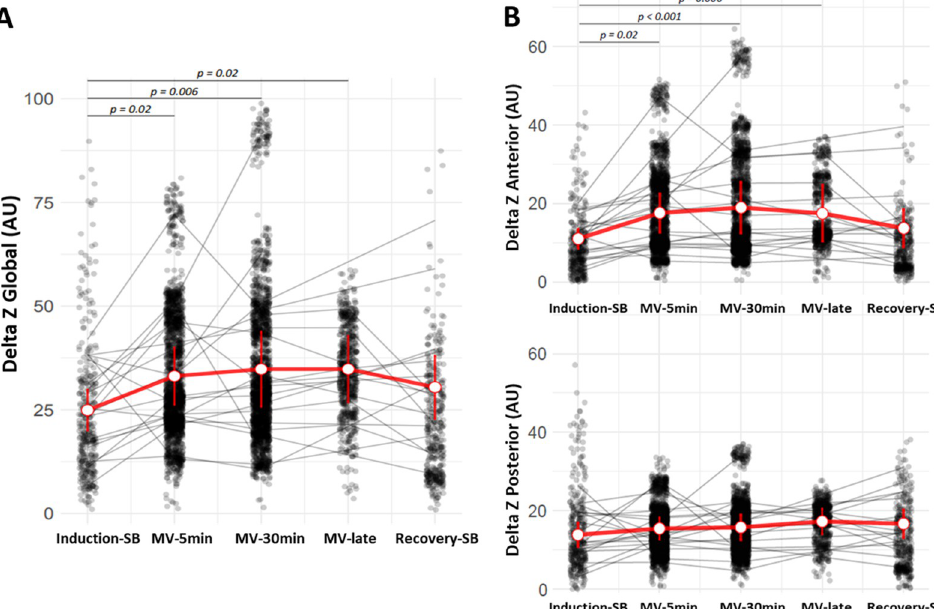
Fig 4. Impedance change (Delta Z) in the global (A) and in the anterior (B) and posterior (C) regions over the five periods: induction-SB, MV-5min, MV-30min, MV-late and recovery-SB. Significant variations were observed in the measurements of global and anterior Delta Z compared all mechanical ventilation time to induction-SB. Gray dots represent multiple measurements (respiratory cycles) at each time point from all patients. Gray lines describe the average behavior from each patient. Error bars represent the confidence interval with mean (open red